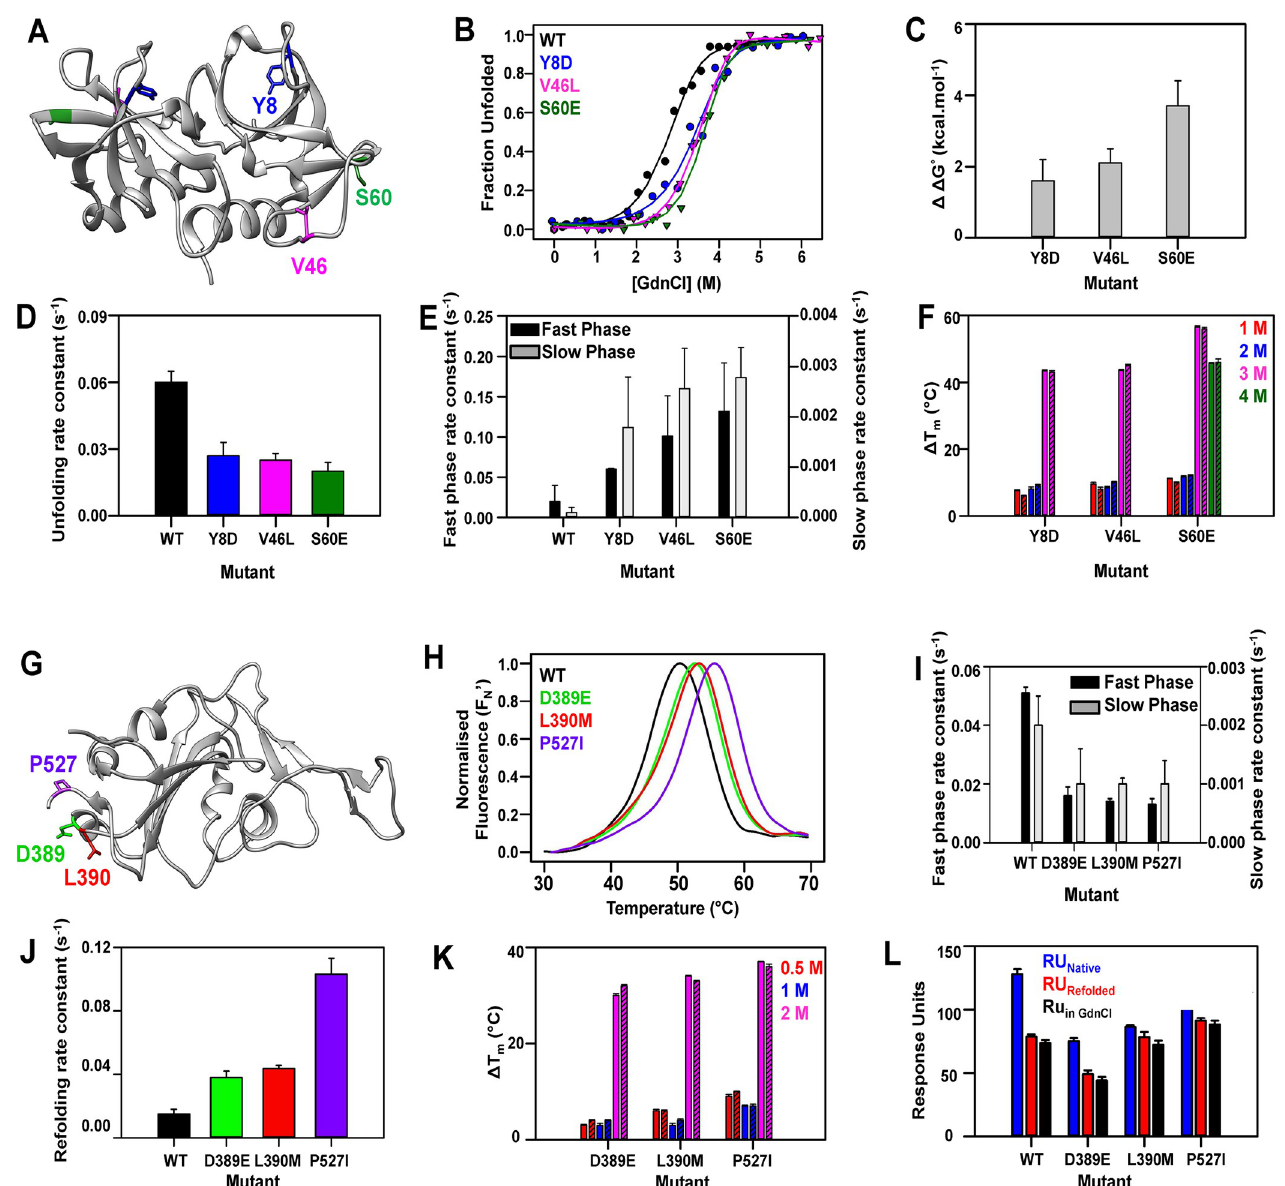
Fig 5. Enhancement in protein stability by highly stable suppressor mutations in CcdB and mRBD. (A-F) CcdB: (A) The distal suppressors Y8D, V46L, S60E located on an exposed region mapped onto the crystal structure of CcdB (PDB ID 3VUB [71]). (B) Equilibrium GdnCl denaturation profiles assayed by nanoDSF. (C) Differences in thermodynamic stability assayed by chemical denaturation, ΔΔ G˚ ð DD G � ¼ D G � suppressor mutants are plotted. (D-E) The observed rate constants of unfolding (4.5 M GdnCl) and the observed rate constants of the fast phase (black) and slow phase (grey) of refolding (2 M GdnCl) of different mutants. (F) The difference in thermal stability, ð D T 1 M, 2M, 3M, 4M GdnCl (solid bars), and refolded CcdB proteins in the same concentrations of GdnCl (striped bars). (G-L) mRBD: (G) The distal suppressors D389E, L390M, P527I located on an exposed region mapped onto the crystal structure of RBD (PDB ID 6ZER [78]). (H) Thermal unfolding profiles of 10 μ M of purified WT and mRBD mutants. (I-J) The observed rate constants of fast phase (black) and slow phase (grey) of unfolding (3 M GdnCl) and the observed rate constants of refolding (0.5 M GdnCl) of different mutants. (K) The difference in thermal stability, ð D T proteins in 0.5 M (red), 1M (blue), 2M (pink) GdnCl (solid bars), and refolded mRBD proteins in the same concentrations of GdnCl (striped bars). (L) Binding of 50 nM of native mRBD proteins (blue), native mRBD proteins in 0.5 M GdnCl (red solid) and refolded mRBD proteins in 0.5 M GdnCl (red striped) with ACE2-hFc neutralizing antibody is shown. The error bars wherever shown represent the standard deviation from two independent experiments, each performed in duplicates.